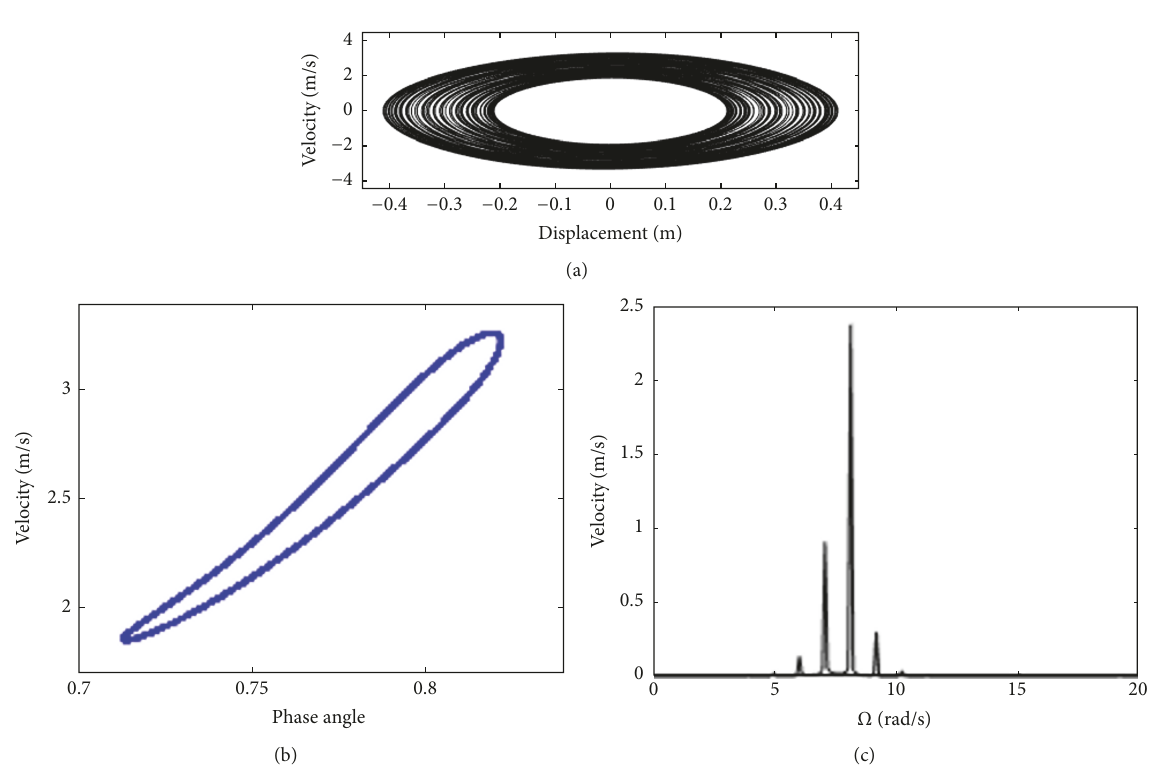
Figure 13: Quasiperiodic orbit at Ω = 8.15rad/s: (a) the phase portrait, (b) the Poincar ´ e map, and (c) frequency